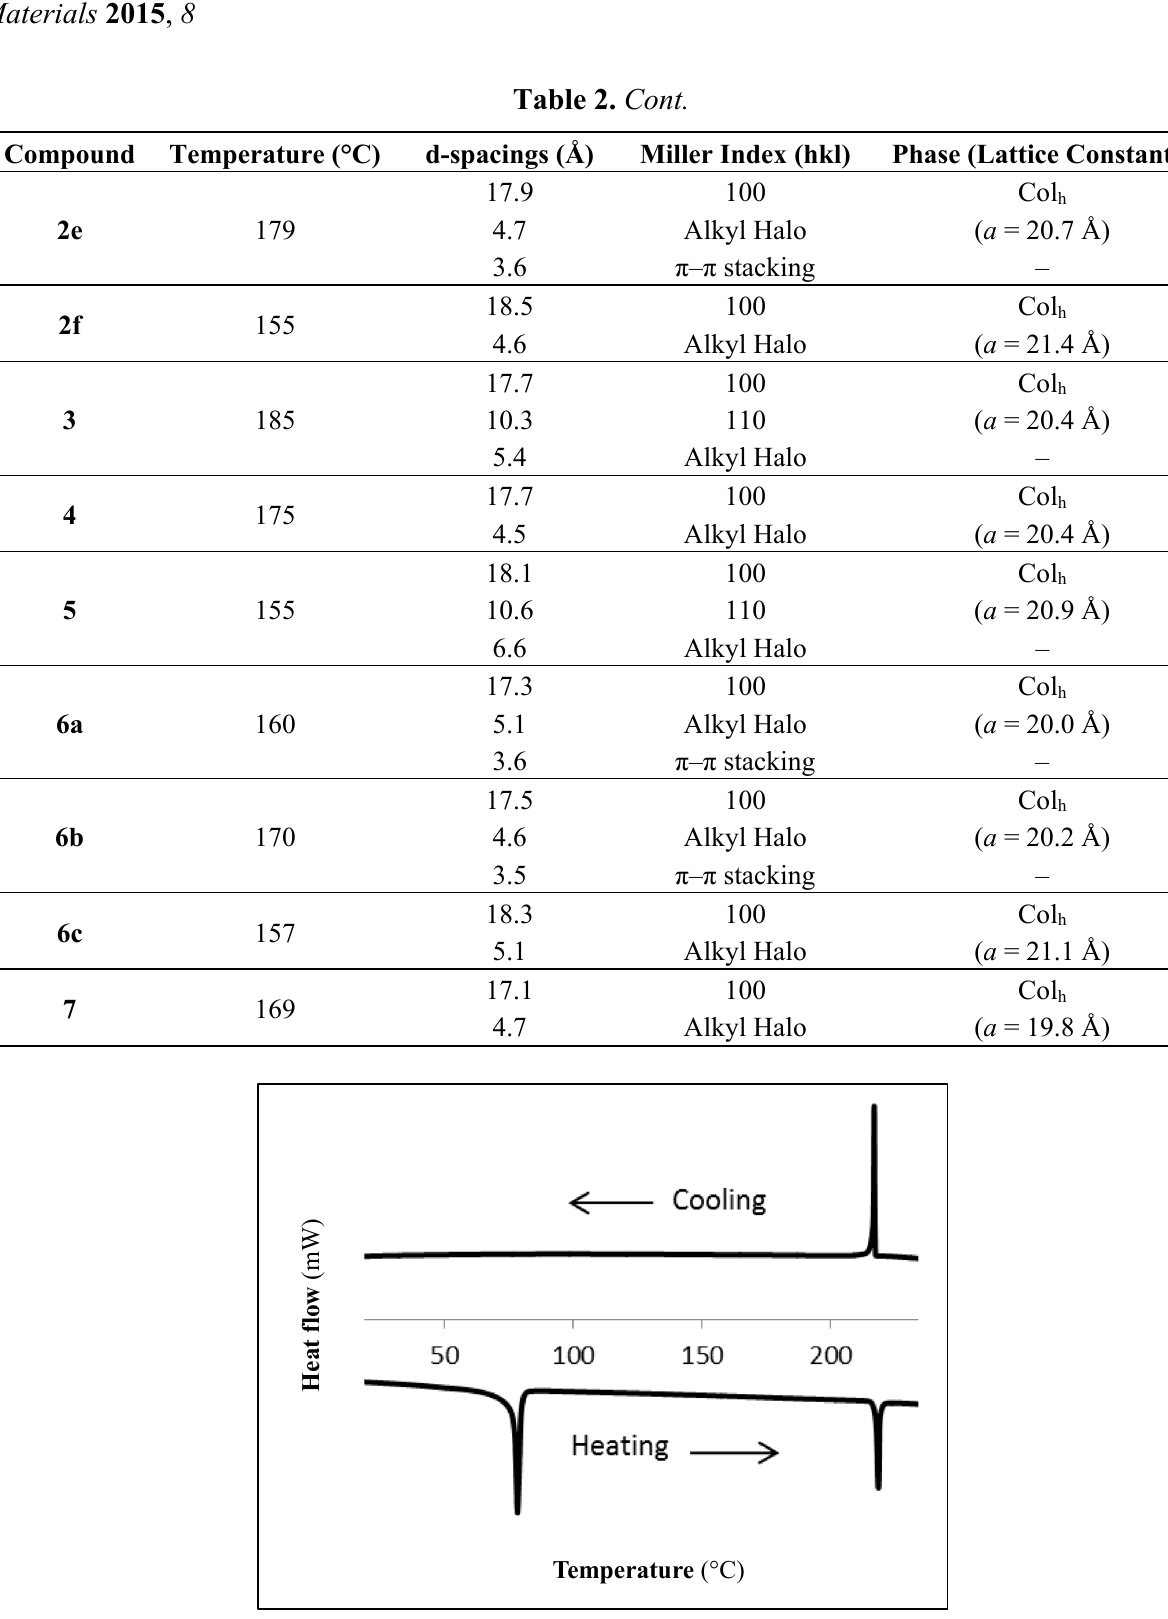
Figure 3. Differential scanning calorimetry (DSC) endotherm and exotherm for first heating and cooling cycle of 3 (heating/cooling rate = 10